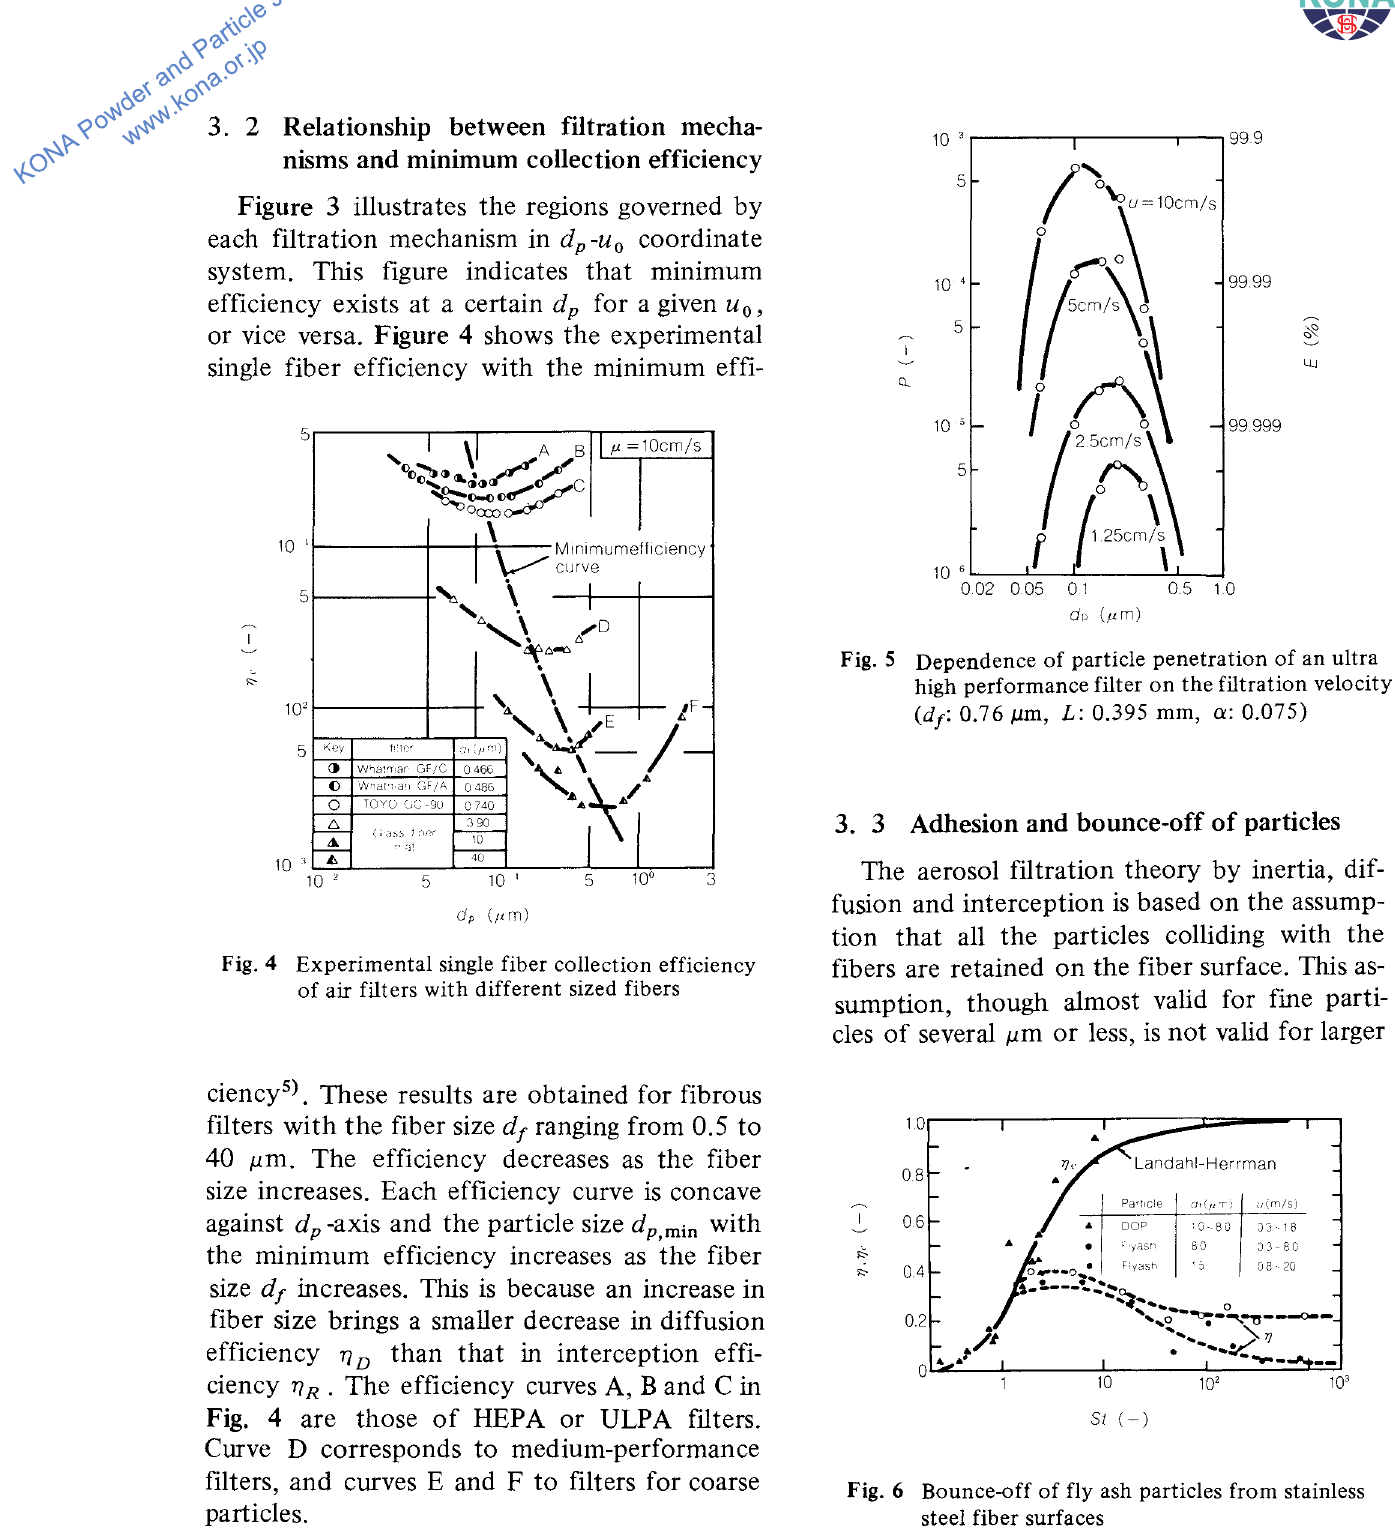
Fig. 6 Bounce-off of fly ash particles from stainless steel fiber surfaces